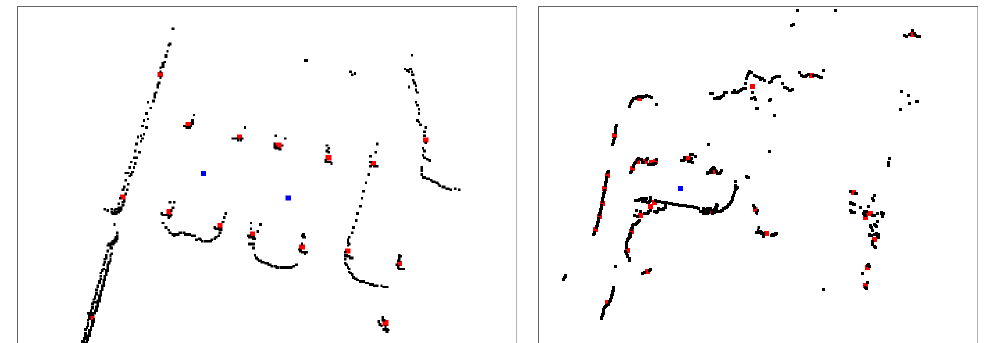
Figure 4. Two images of laser scans captured by the car transporter in different weather conditions. The images are captured by transforming the LiDAR points from each sensor into a common coordi- nate system, and then projecting the resultant data into a top-down image. In both images, the car transported is positioned off-image, directly below the centre. ( Left ): From clustering and geometry, we can detect cars reasonably well in good weather. The centres of the clusters are shown as red points. The blue points show the centre of the cars as found by the geometrical analysis of the clusters. Note that in ideal conditions, we already have several clusters that appear to not be associated with cars and one car that fails to be detected. ( Right ): Severe weather often affects the reflective properties of light, distorting the data and making the identification of cars difficult, even for human